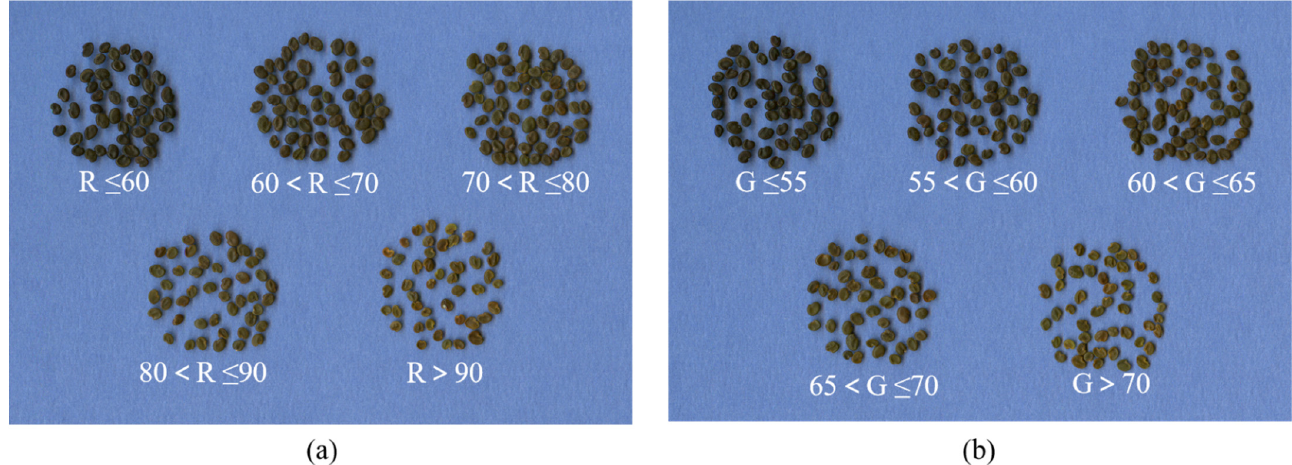
Figure 7. Astragalus seeds from the R value ( a ) and G value ( b ) subsamples showing variations in color.